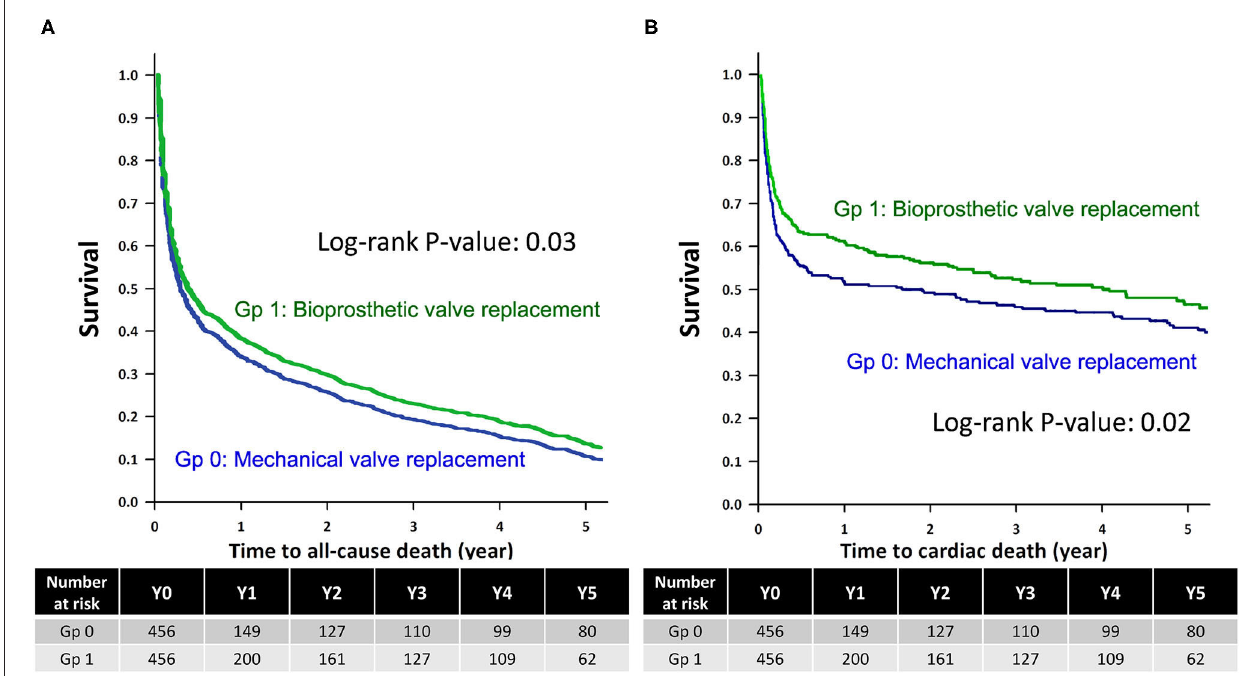
FIGURE 2 | Kaplan–Meier survival analysis of the ESRD group. Kaplan-Meier survival analysis for (A) all-cause mortality and (B) cardiovascular deaths among ESRD patients who underwent mechanical valve replacement (Gp 0) and bioprosthetic valve replacement (Gp 1), with the statistical significance examined using the Log-rank test. ESRD, end-stage renal disease; Gp, group.